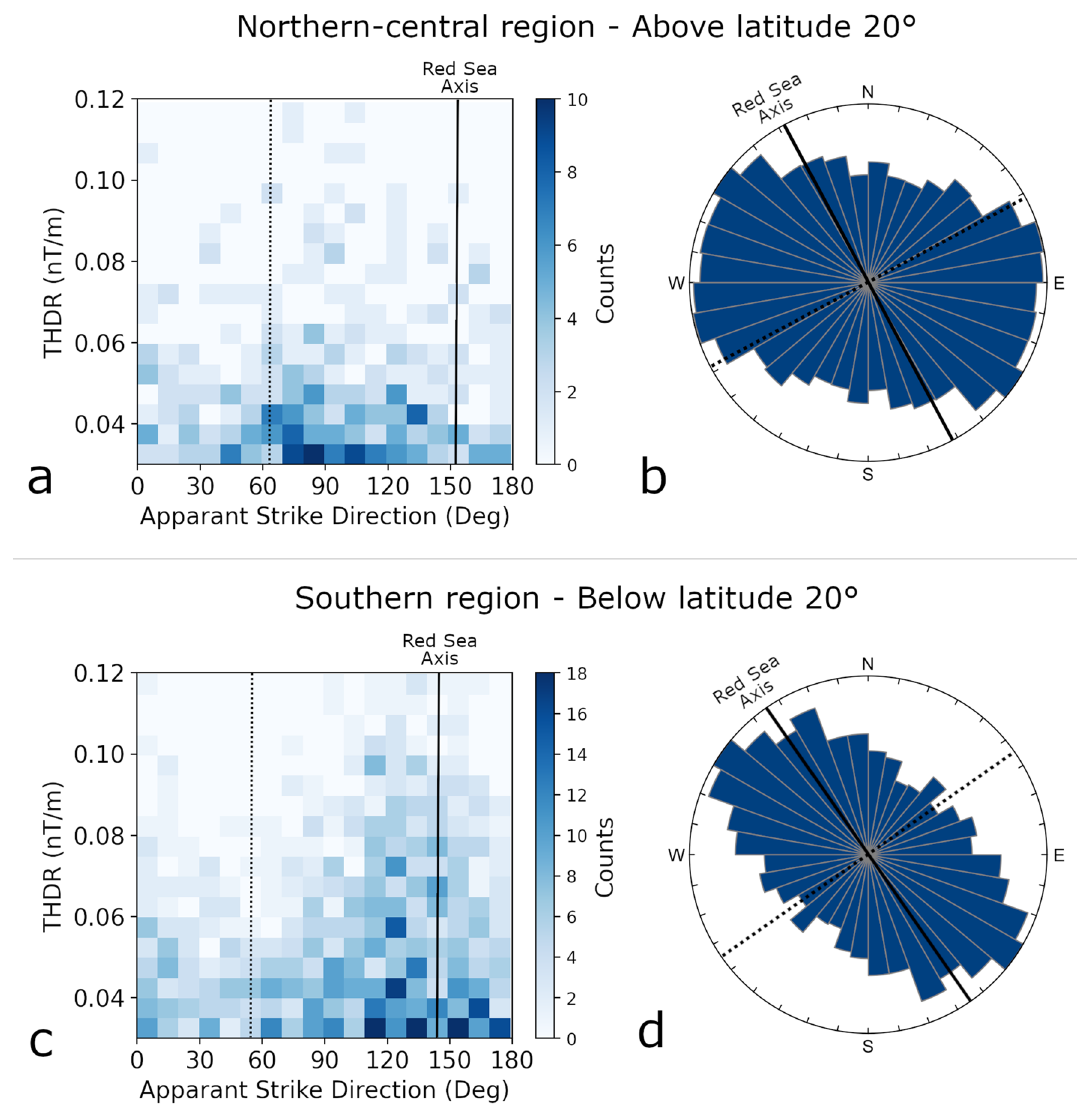
Figure 6. Apparent strike analysis of magnetic anomalies. 2-D histograms ( a , c ) shows the distribution of the total horizontal derivative (THDR) and azimuth of apparent strikes. The apparent strike is the direction perpendicular to the horizontal gradient. Ros diagrams ( b , d ) shows frequencies of apparent strike directions, produced with 10° bins and equal distance projection. Solid black line marks the average orientation of the Red Sea axis and its perpendicular direction (dashed black